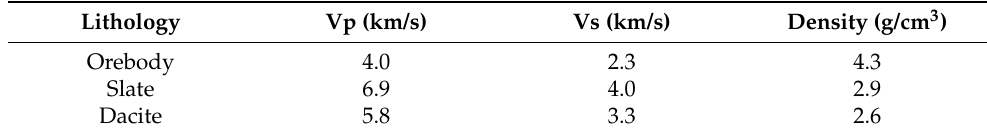
Table 4. Elastic parameters used in the Zaozigou